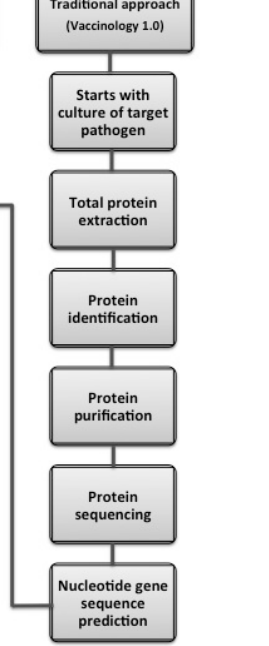
Figure 2. Pipeline showing how recent advances in molecular biology, immunology, genetics, systems biology, and bioinformatics have shortened the alternative routes to vaccine development, facilitating the transition from traditional to the reverse